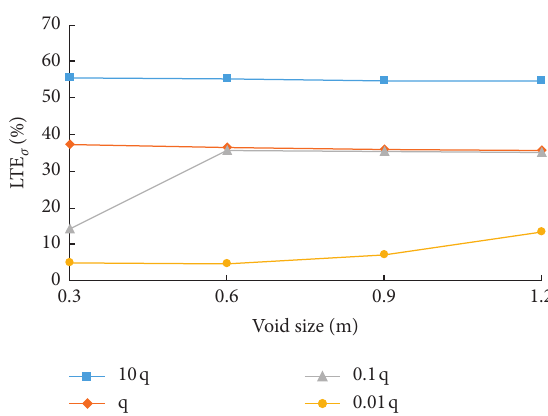
Figure 13: Relationship between void size and LTE